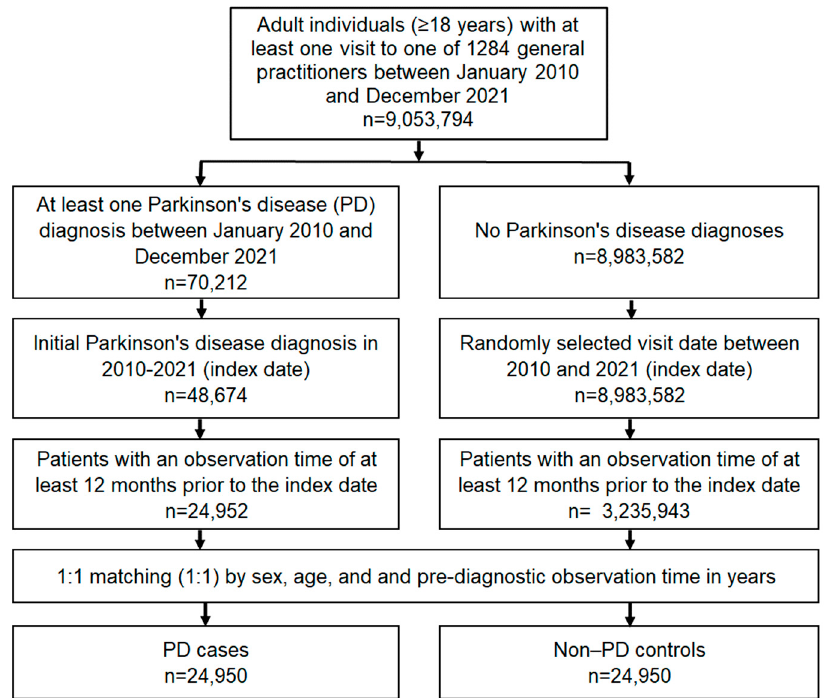
Figure 1. Flow diagram concerning study participants.